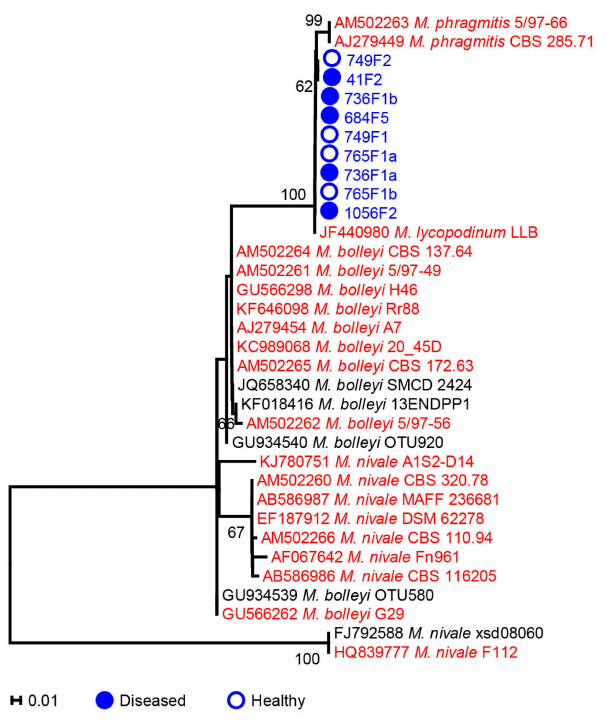
Figure 2. Phylogenetic tree of ITS rRNA sequences of nine Microdochium isolates from salmon eggs and reference strains. The phylogenetic analyses were conducted in Mega 5 using the Kimura 2-parameter method [48] to compute evolutionary distances. The bootstrap values indicated at the nodes are based on 1000 bootstrap replicates. Branch values lower than 50% are hidden. Closed and open circles indicate Microdochium isolates from Saprolegnia -infected (diseased) or healthy salmon egg samples, respectively. Red, blue and black colors indicate strains from terrestrial/plant, aquatic and unknown sources of isolation, respectively. The scale bar indicates an evolutionary distance of 0.01 nucleotide substitution per sequence position. Twenty-five ITS sequences of good quality and at least 550 bp of reference strains of Microdochium were downloaded from GenBank; their strain names are preceded by the accession numbers.